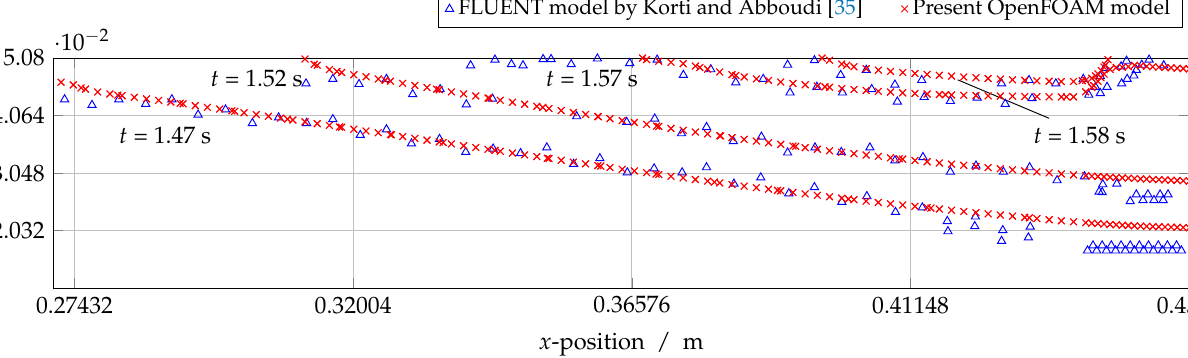
Figure 4. Benchmarking of the presented OpenFOAM model with previously published data by Korti and Abboudi [35]; the figure shows the interface positions at various time